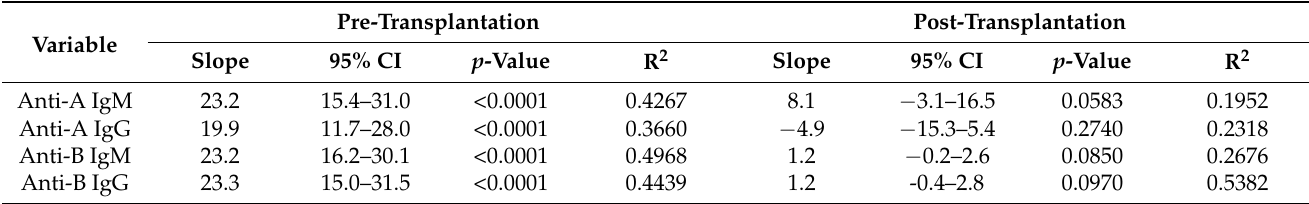
Table 1. Simple linear regression analysis results of hemolysis (%) related to ABO Ab titers.